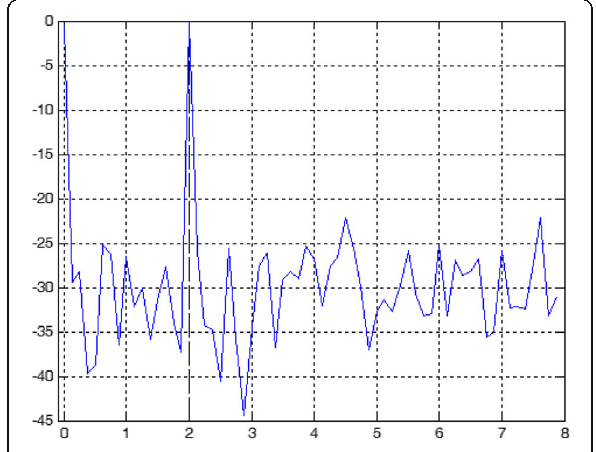
Fig. 3 The power of time domain pulse response with SNR = 10 dB. In Fig. 3, X -axis is the power of time domain pulse response (dB) and Y -axis is time